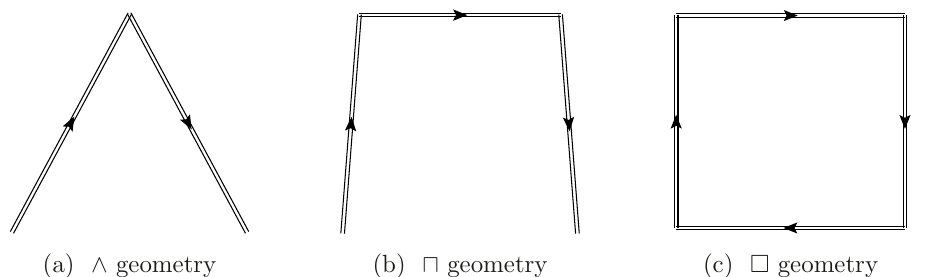
Figure 1. Contours of lightlike Wilson loops that contain semi-infinite Wilson lines, which arise in the factorisation of the form factor (a) and the parton distribution function (b). Contour (c), the parallelogram, which consists of four finite lightlike segments, gives rise to the anomalous dimension on the right-hand-side of eq.